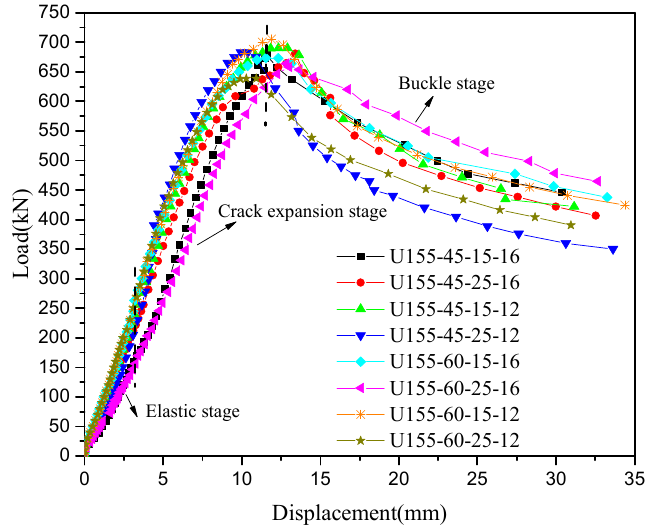
Figure 10. Load-deflection curves of steel-UHPFRC composite beams.